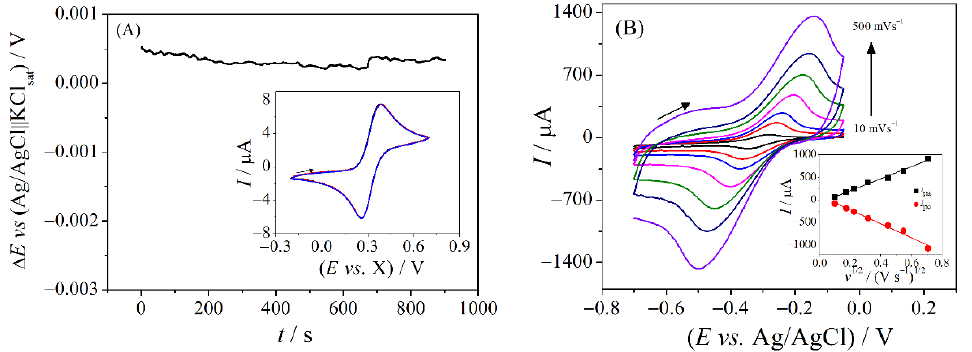
Figure 2. ( A ) Chronopotentiometric analysis comparing the behavior of the Ag/AgCl pseudo- reference electrode inkjet-printed on paper against a commercial Ag/AgCl (saturated KCl solution). The insets are cyclic voltammograms obtained using a glassy carbon electrode and the pseudo- reference electrode (duplicate) or commercial Ag/AgCl in the presence of 1.0 mmol L −1 K 3 [Fe(CN) 6 ]